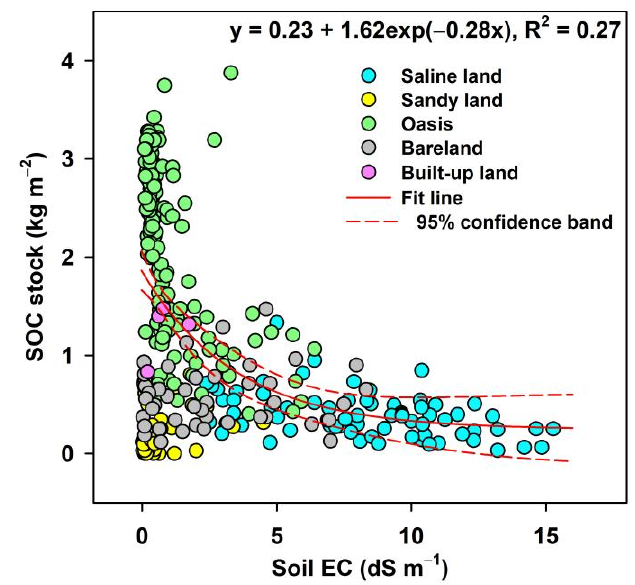
Figure 8. Nonlinear relationship between SOC stock and soil EC based on site-level measurements.